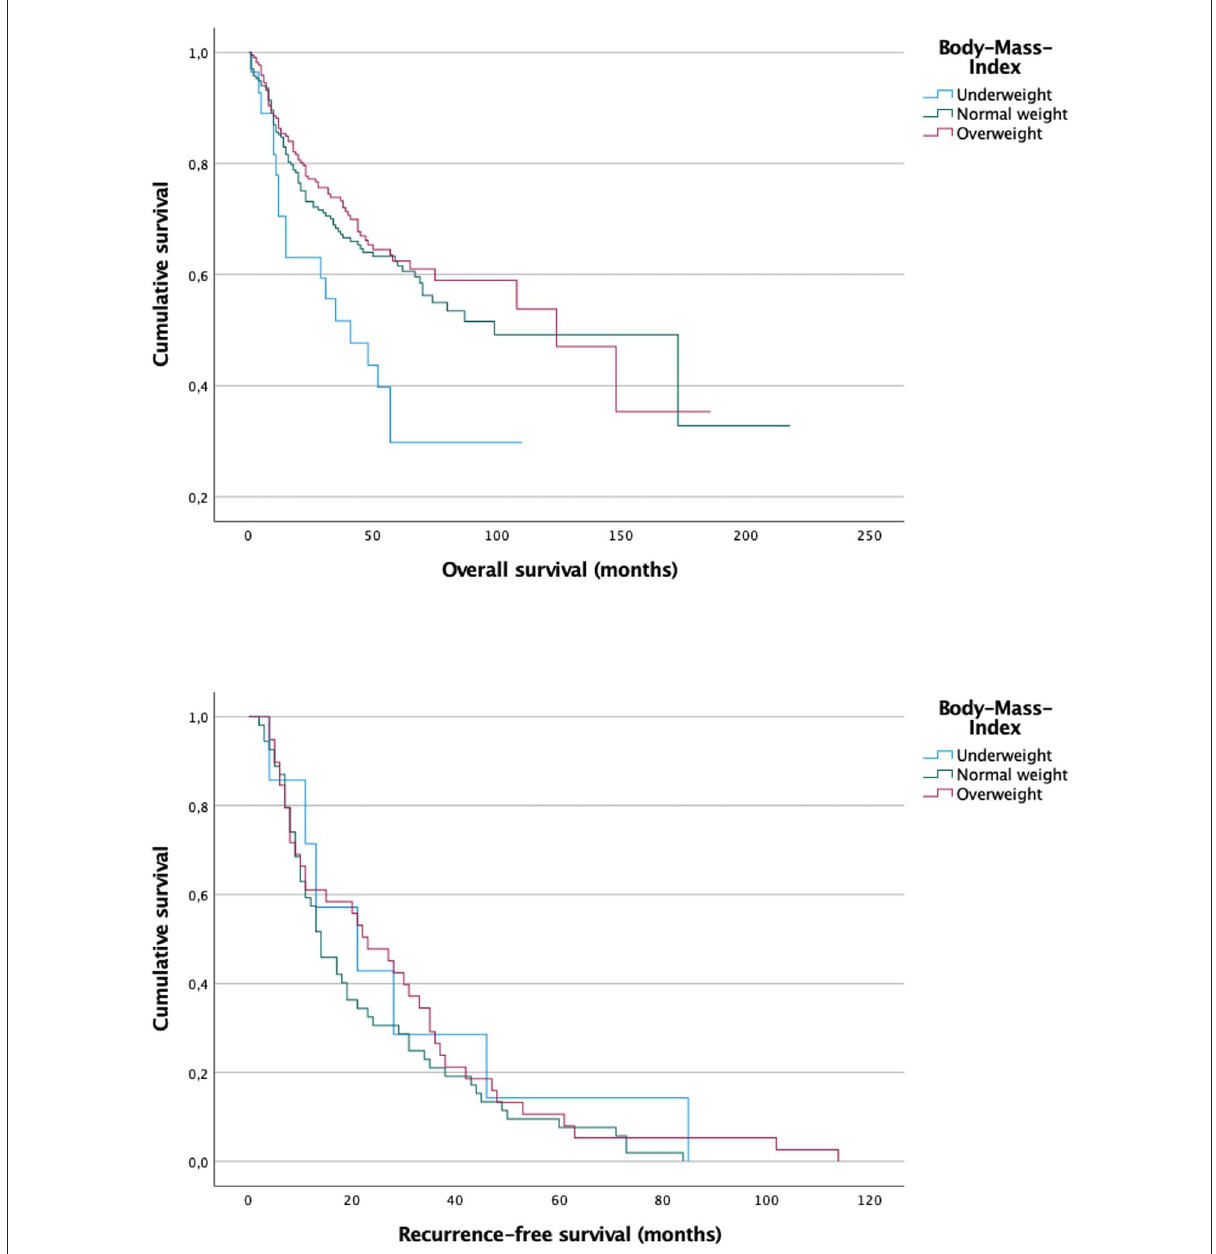
FIGURE4 Survival curves for underweight, normal weight and overweight patients. A significant difference could be observed between underweight patients compared to the other groups in overall survival ( p = 0.012). While underweight patients had a mean overall survival of 4.2 years normal weight and overweight patients had a mean overall survival of 9.7 and 9 years, respectively. There was no significant difference in recurrence-free survival between the three groups ( p =